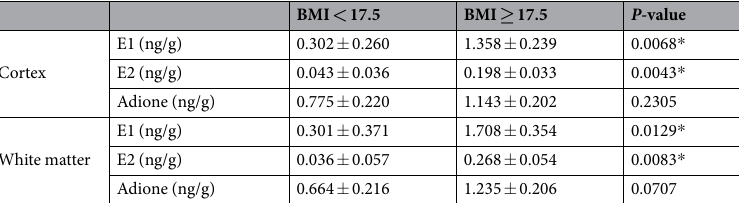
BMI < 17.5 BMI ≥ 17.5 P -value